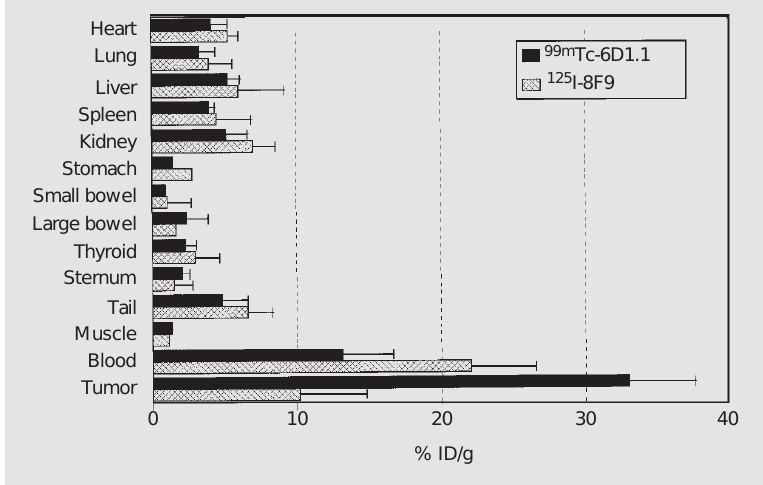
Figure 5 - Biodistribution of radiolabeled mAbs injected simultaneously in mice xenografted with the LS-174T line and analyzed 24 h after injection. Black bars represent 99m Tc-6D1.1 anti-CEA mAb and grid bars, unrelated 125 I-labeled mAb 8F9. Results are reported as % of injected dose per gram of tissue (% ID/g) obtained as the mean values ± SD from three animals.